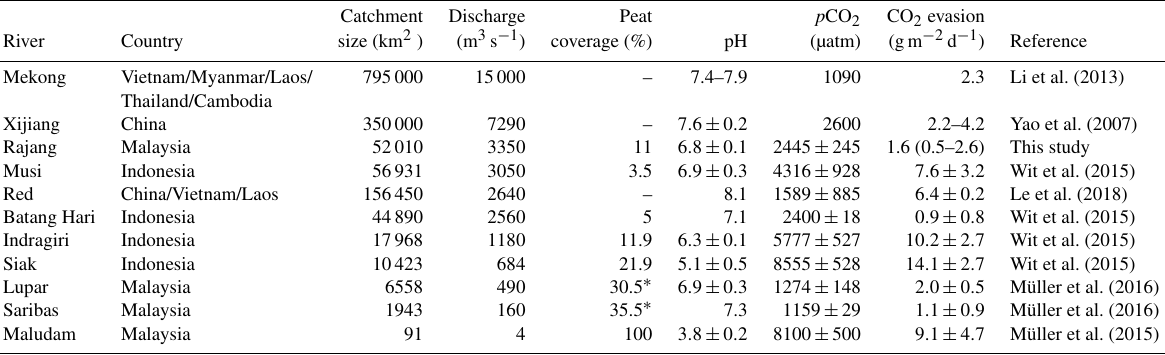
Table 4. p CO 2 , pH and CO 2 evasion of several Southeast Asian rivers flowing into the South China Sea.